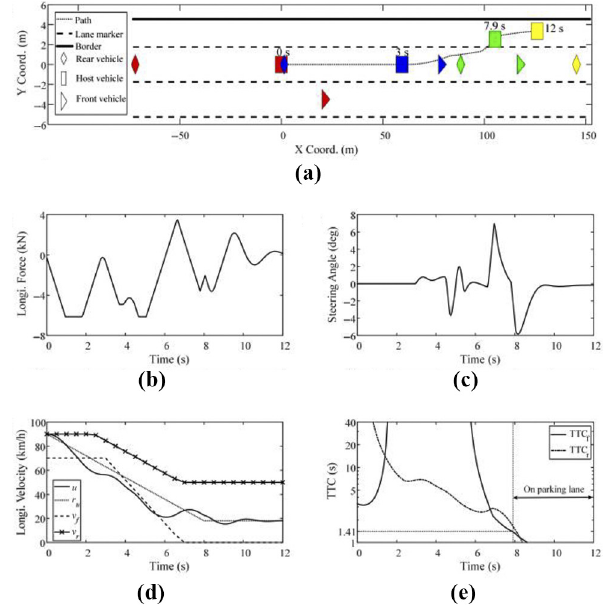
Figure 10 Numerical analysis results of scenario 4 Figure 9 Numerical analysis results of scenario